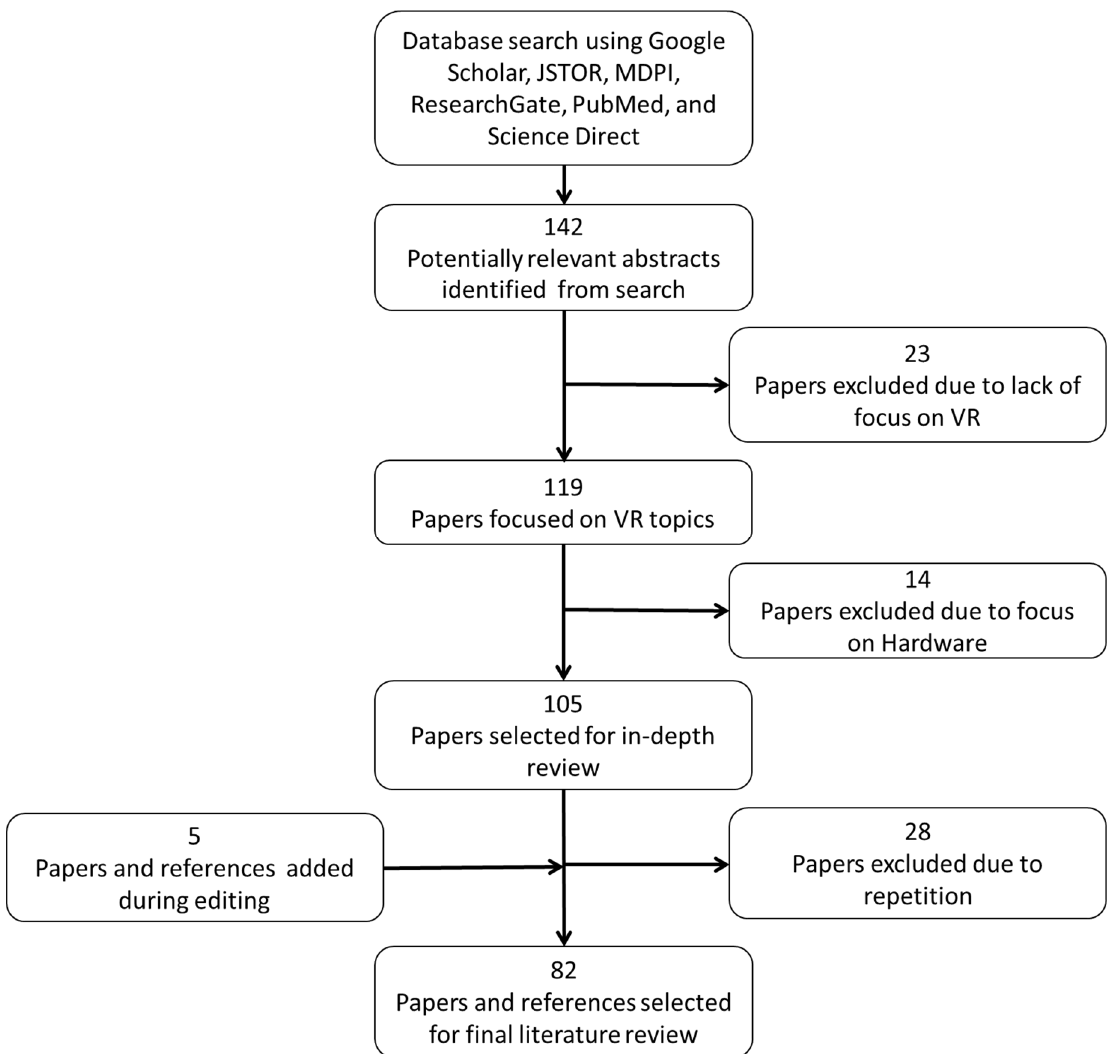
Figure 1. General structure of the paper selection and literature review.